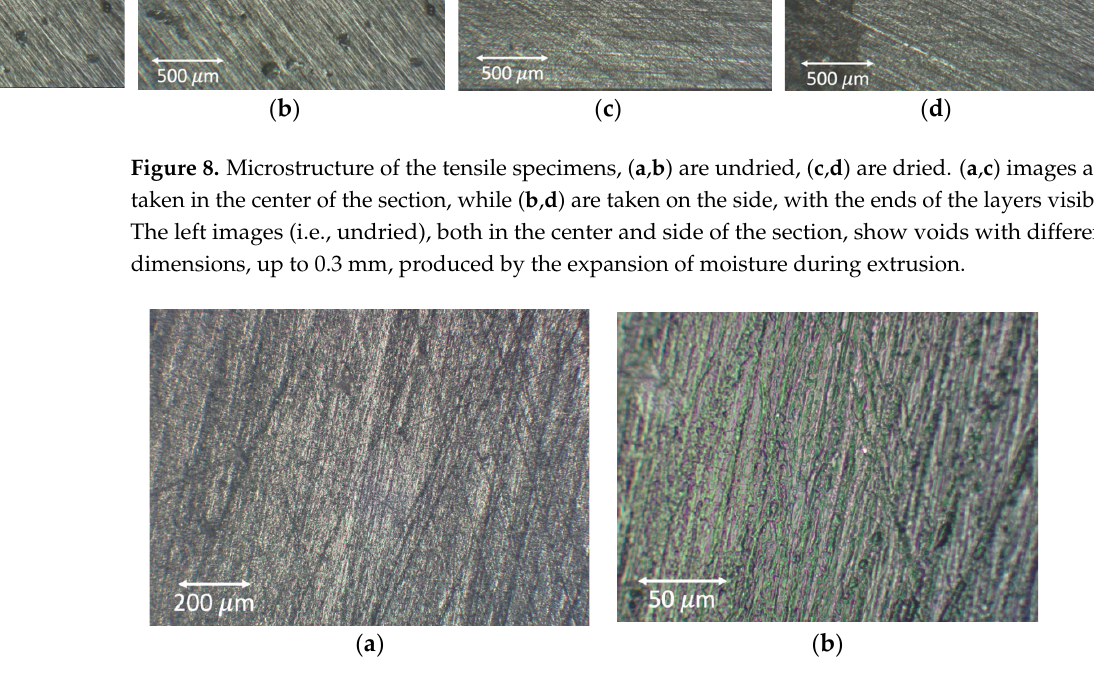
Figure 9. Microstructure at different magnifications of an adequately dried sample; a uniform and continuous structure visible.